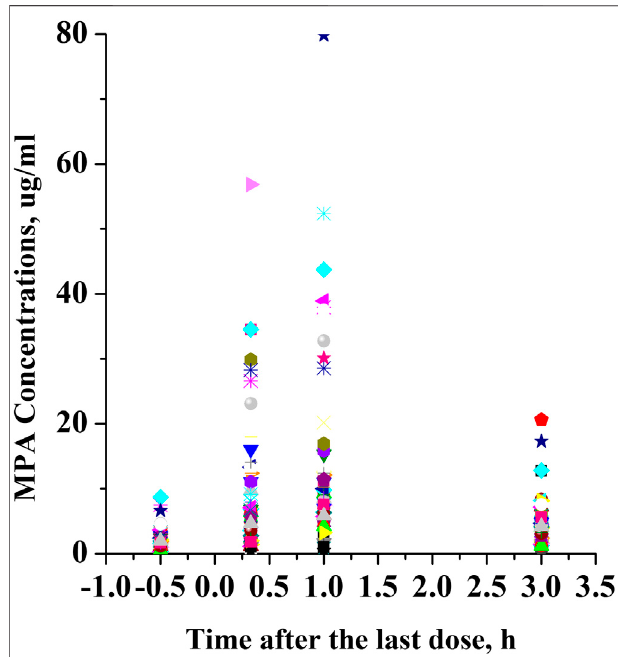
FIGURE 1 | Individual MPA concentration-time pro fi